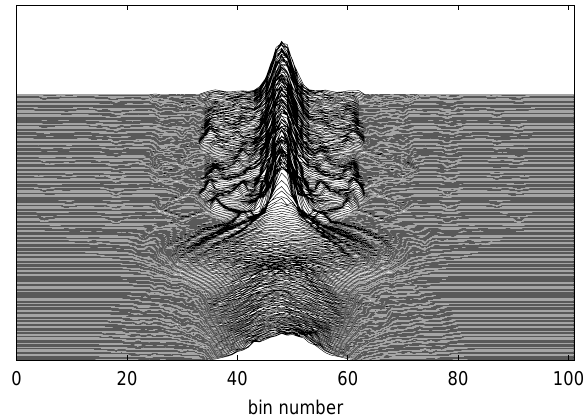
FIG. 5. Mountain range plot of 250 profiles, obtained from a reconstructed phase space distribution using nominal machine parameters. The time between profiles correponds to 20 revolu- tions of the beam in the